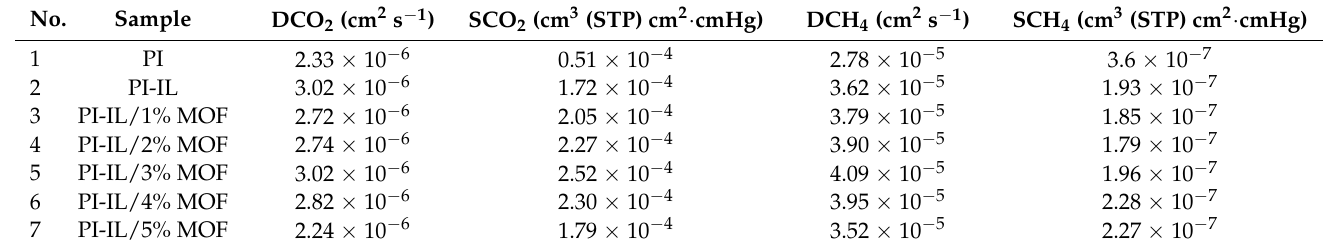
Table 4. CO 2 and CH 4 solubility and diffusivity coefficients of membranes measured at 34 ◦